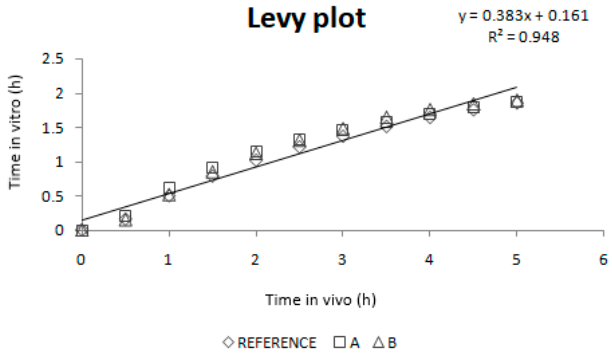
Figure 7. Levy plot and the Inverse Release Functions (IRF).